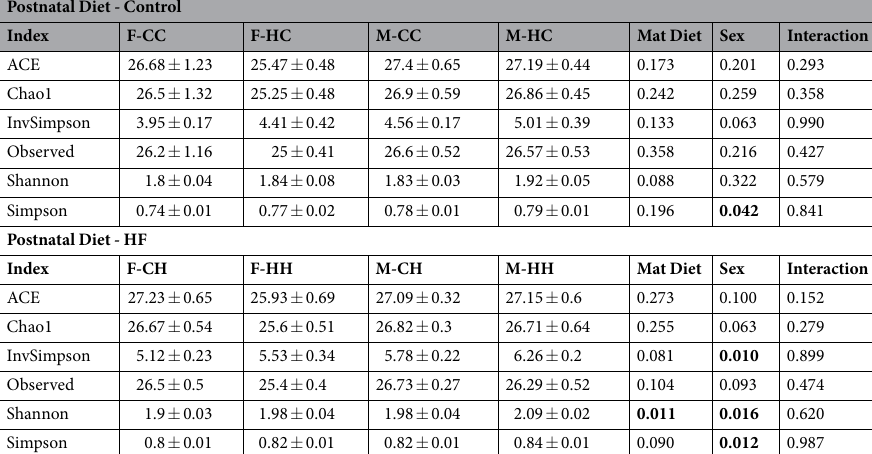
Postnatal Diet - Control